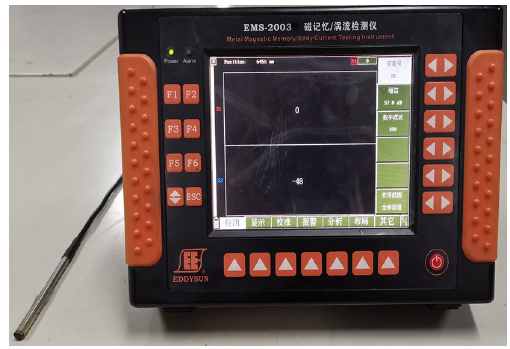
Fig. 14 Magnetic memory detector